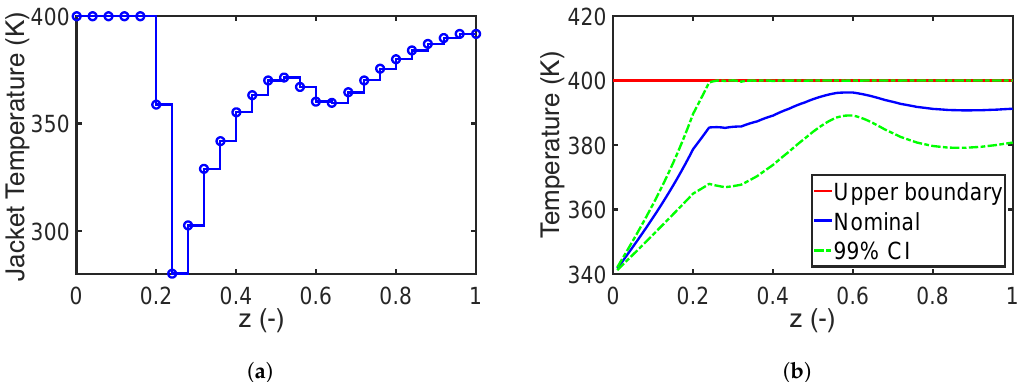
Figure 6. Results for robust design with parameter correlation: ( a ) the optimal jacket temperature profile and ( b ) the reactor temperature and its 99% confidence interval (CI). The mean and standard deviation of the conversion of reactant A are 0.986 and 0.008, respectively.